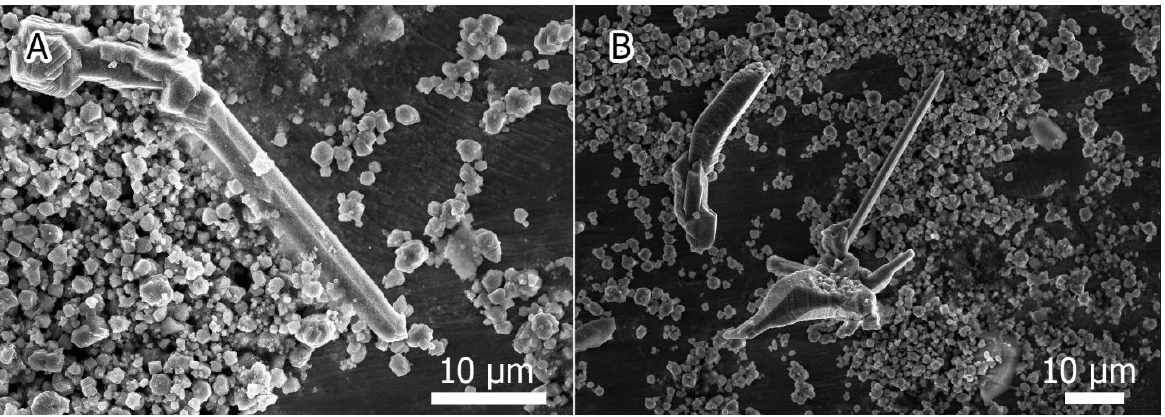
Figure 3. Faceted crystallites and microrods observed in Si:Te sample: ( A ) large tetrahedral rod; ( B ) druses.